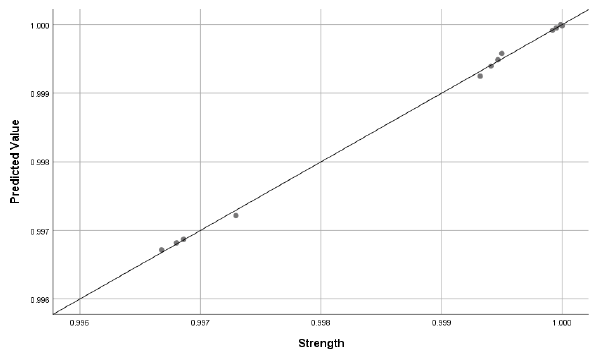
Figure 7: Laboratory Strength Vs Predicted Strength